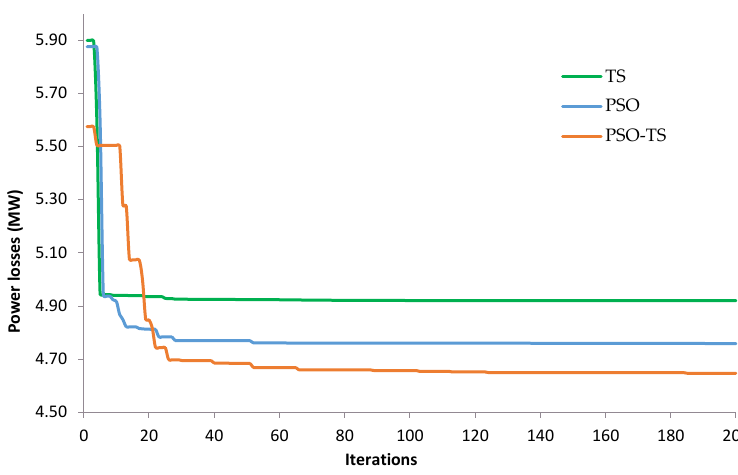
Figure 10. Convergence characteristic of the power losses (Case 2). Table 4. Experimental results of TS, PSO and PSO-TS algorithms (Case 2).